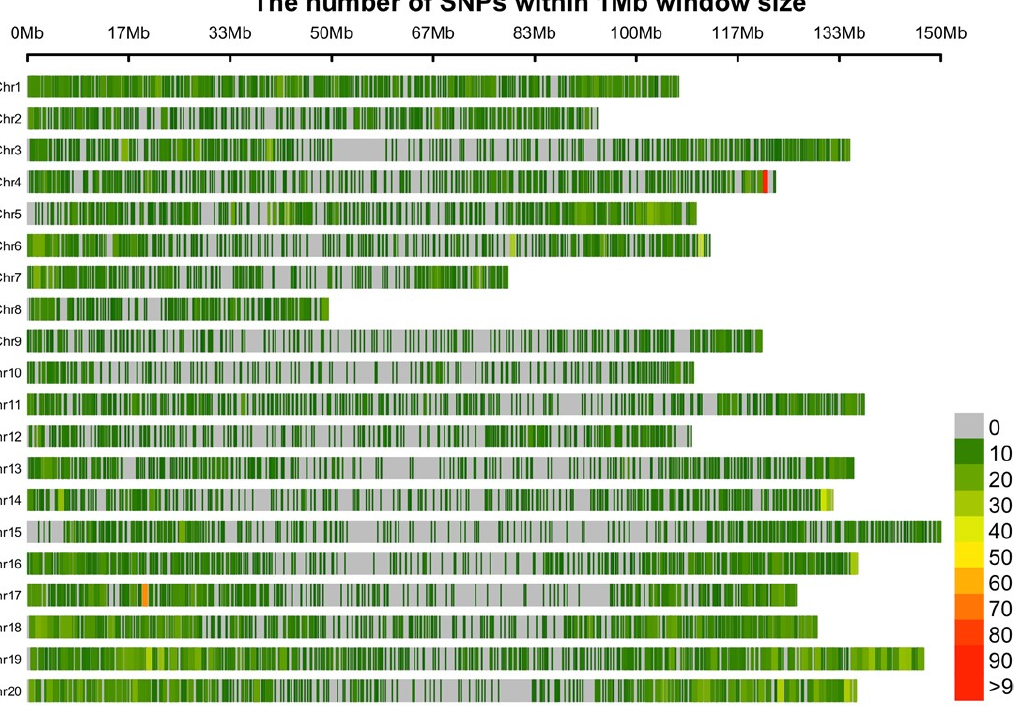
Figure 1. Distribution of SNP markers in the 20 chromosomes from genotyping of the association panel on the peanut genome. Horizontal axis represents physical distance along each chromosome. The color pattern on each chromosome indicates density of marker in the region of 1Mb window